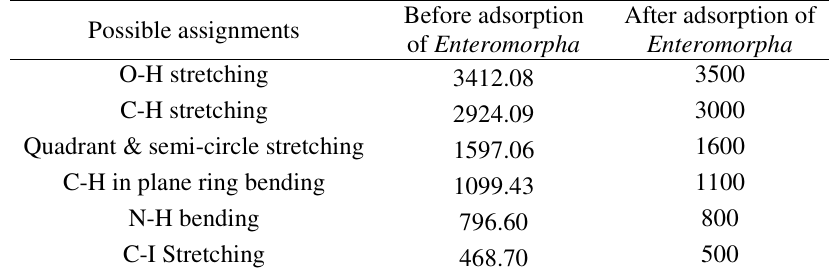
Table 8. Some fundamental FTIR frequencies of Enteromorpha before and after